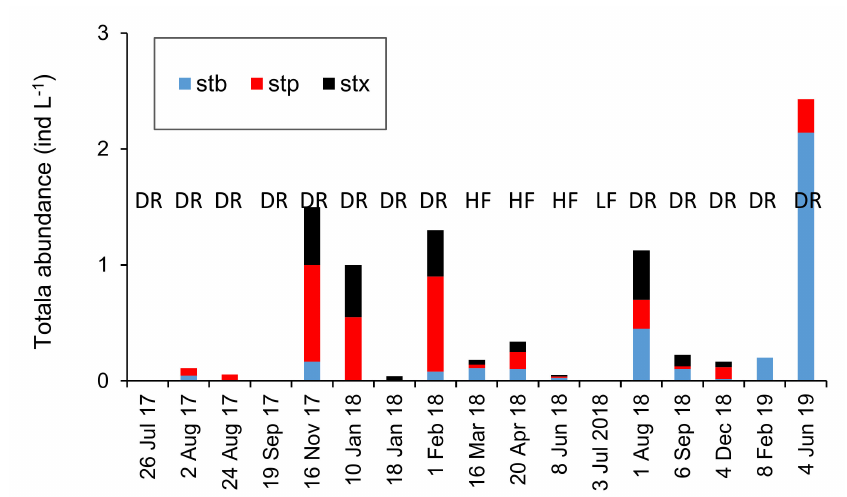
Figure 4. Deep intermittent site (i.e., int-3), total abundances of the three faunistic groups for each sampling occasion. Surface water hydrological phase abbreviated as: drought = DR; high flows = HF; low flows = LF. Stx = stygoxenes; stp = stygophiles; stb =